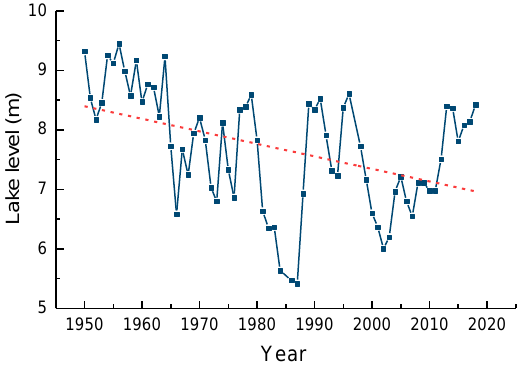
Figure 2. Historical average annual lake level of Baiyangdian Lake.